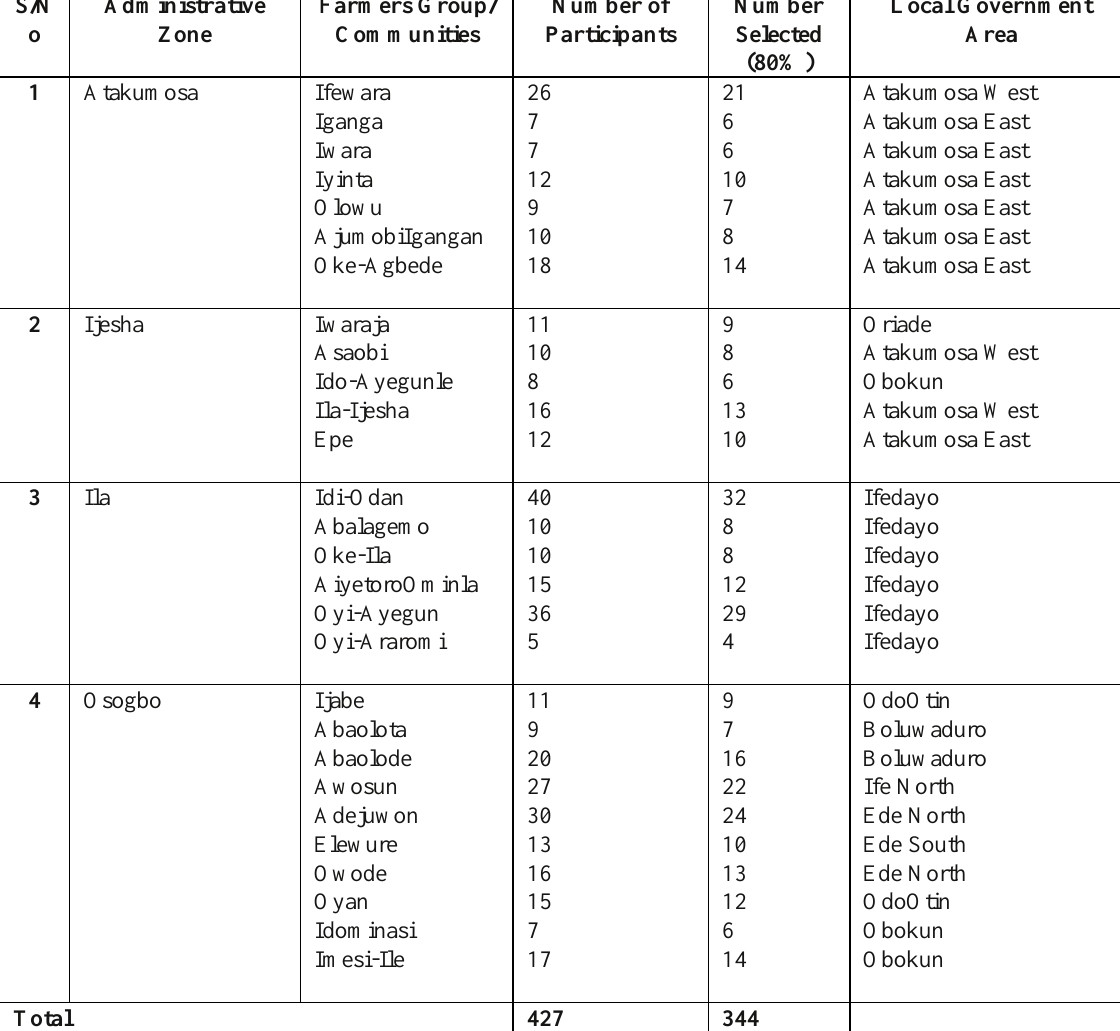
Table 1. Distribution of Respondents by Location and Local Government